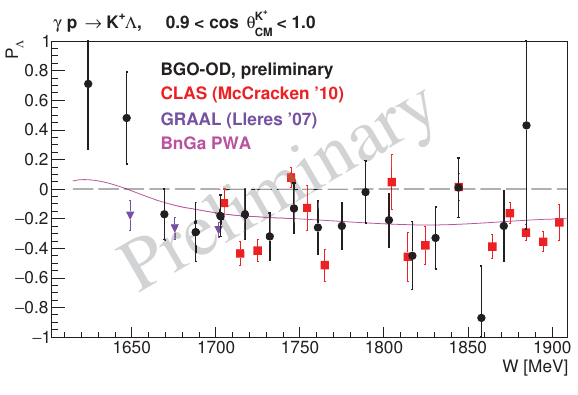
> 0 . 9 (black CM Figure 20. γ p → K + Σ 0 di ff erential cross section for 0 . 92 < cos θ CM < 0 . 94 and cos θ CM > 0 . 98 (red and blue points respectively). Systematic errors for the more backward angle in- terval are the filled grey bars on the